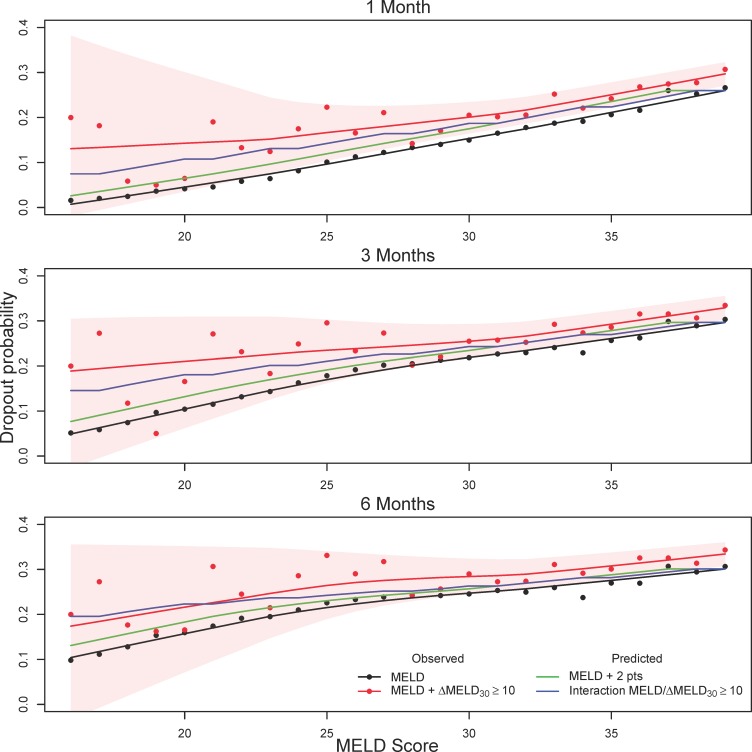
Observed versus predicted one, three, and six month waitlist dropout.Observed versus predicted one, three, and six month waitlist dropout from the first time a given MELD score is obtained for patients experiencing a ΔMELD30 ≥ 10 jump. Red points and smoothed red lines are observed probabilities for patients experiencing a ΔMELD30 ≥ 10 jump, while black points and smoothed black lines are observed probabilities for patients not experiencing a ΔMELD30 ≥ 10 jump. Red shaded regions are pointwise 95% confidence intervals for patients with ΔMELD30 ≥ 10, where the upper and lower limits have been smoothed for better presentation. The green line indicates the predicted dropout for actual MELD plus two points (based on Model #4 in Table 2), while the blue line indicates the predicted dropout for the MELD / ΔMELD30 ≥ 10 interaction model (Model #5 in Table 2, with increase in MELD score given in Table 4). Based on UNOS/OPTN data for registrants added to the liver transplant waitlist between 06/30/2003 and 6/30/2013.